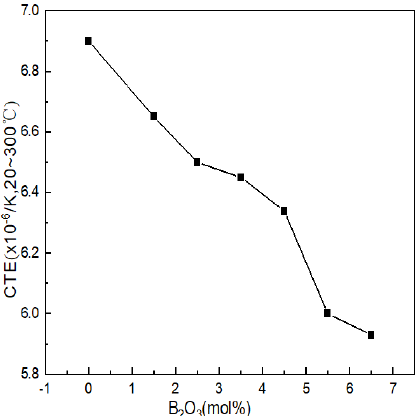
Figure 5. Curve of thermal expansion coefficients of Li 2 O − Al 2 O 3 − SiO 2 system glass with different